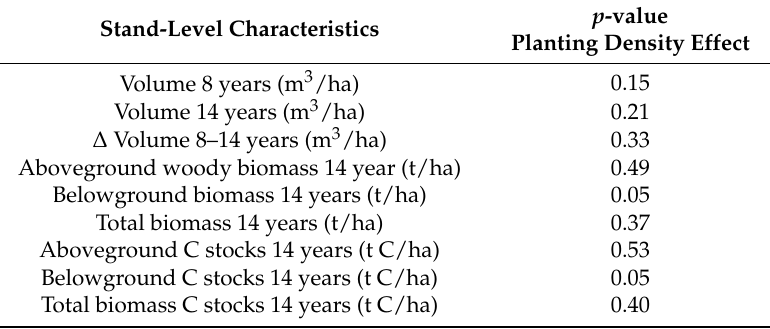
Table A2. Probability value ( p -value) of the Planting density effect on stand-level characteristics following the removal of the 1111 trees/ha treatment in the ANOVA.